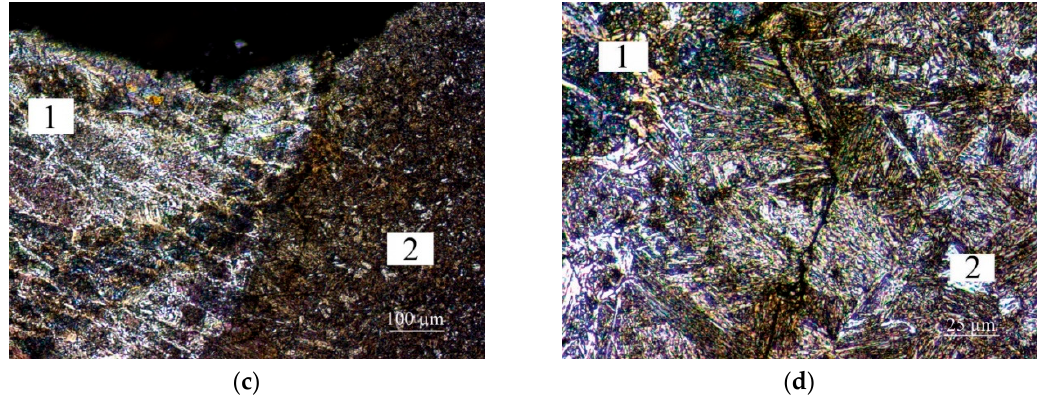
Figure 4. Results of CTS microscopic testing shows cracks in HAZ, 1—weld metal, 2—HAZ, ( a ) Specimen 1; ( b ) Specimen 2; ( c ) Specimen 3; ( d ) Specimen 6. Etch. Nital 4%.